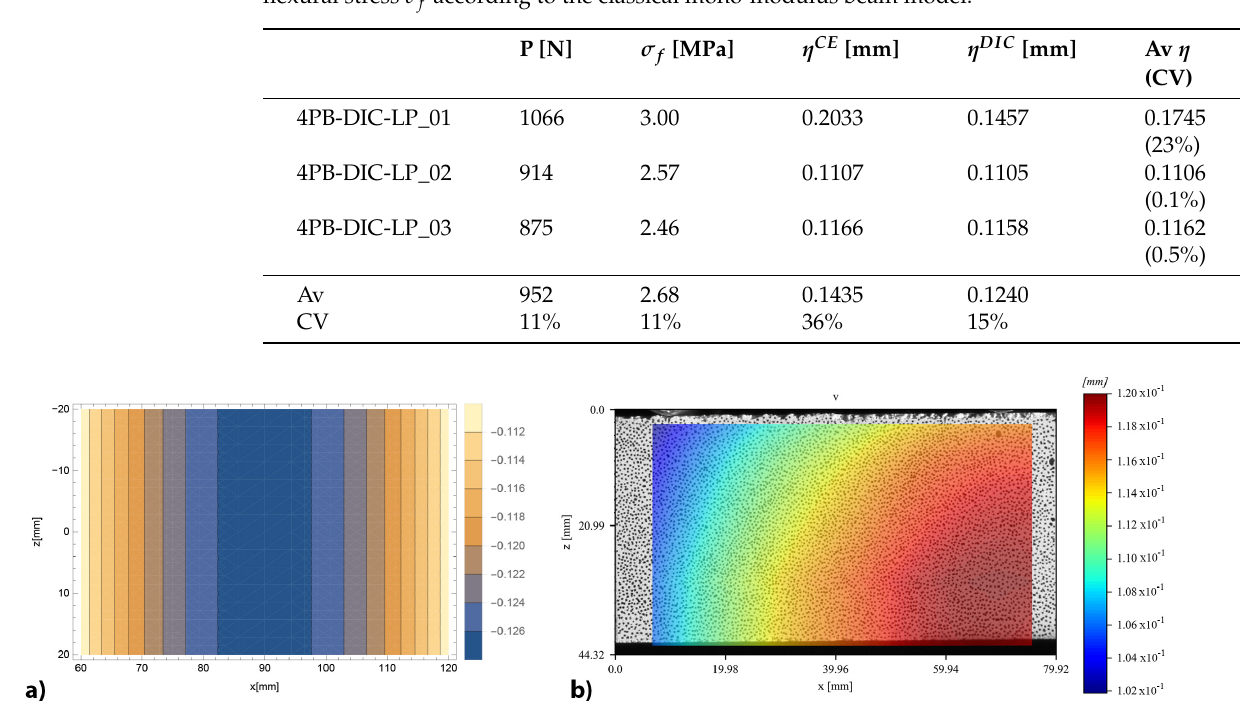
Figure 11. Vertical displacements contour of 4PB-DIC-LP_02 sample: ( a ) prevision obtained by the bi-modulus model ( b ) results obtained by DIC